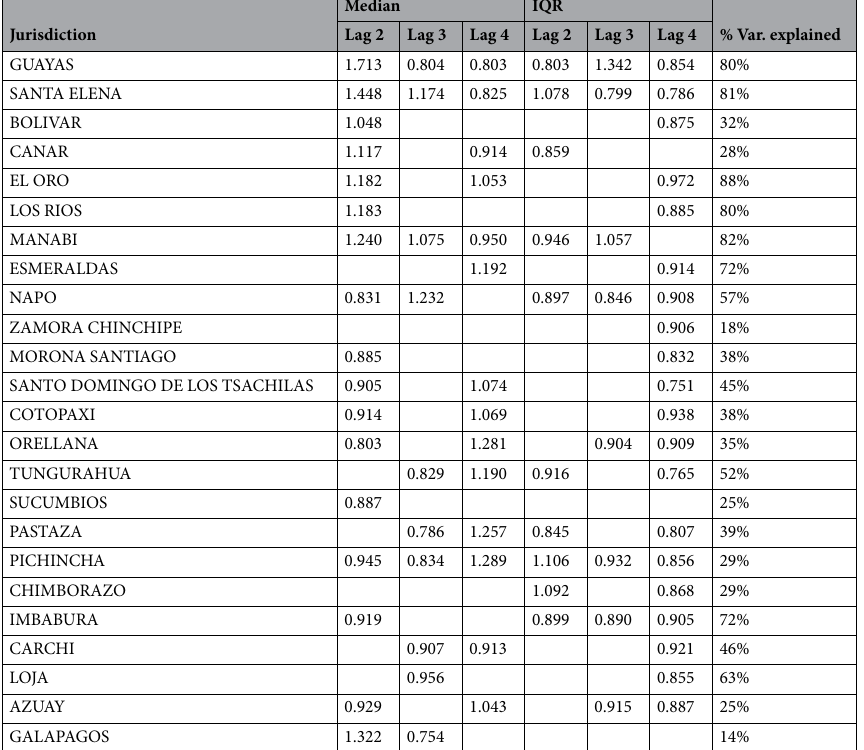
Table 1. Multiplier for the expected excess death factor from a 10% decrease of mobility statistics